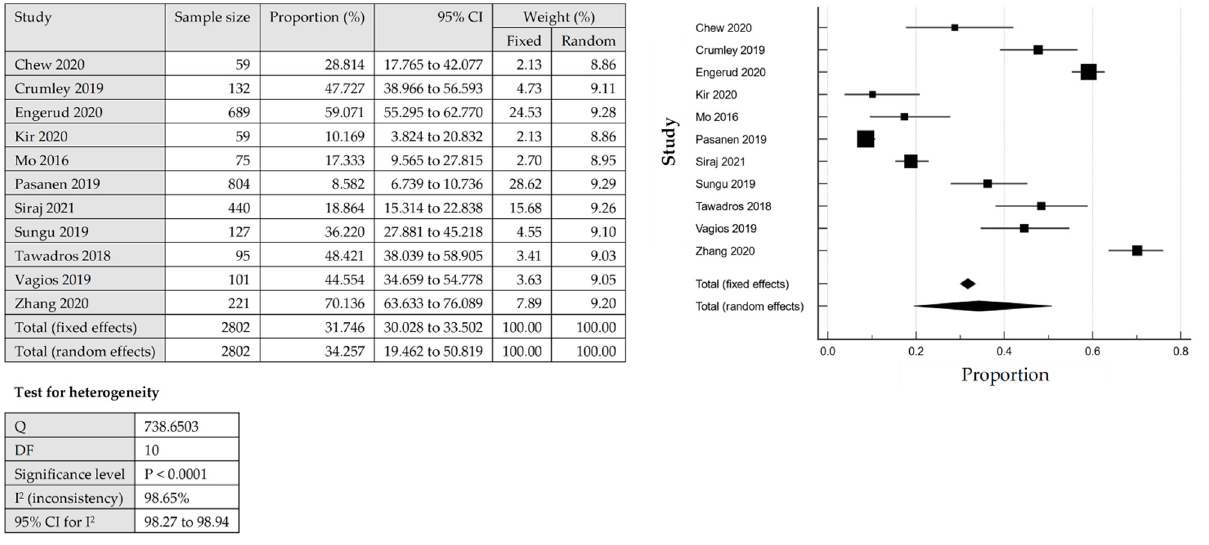
Figure 2. The pooled prevalence of PD-LI positive expression in the tumour cells (TCs) among endometrial cancer cases [17–19,24–31].